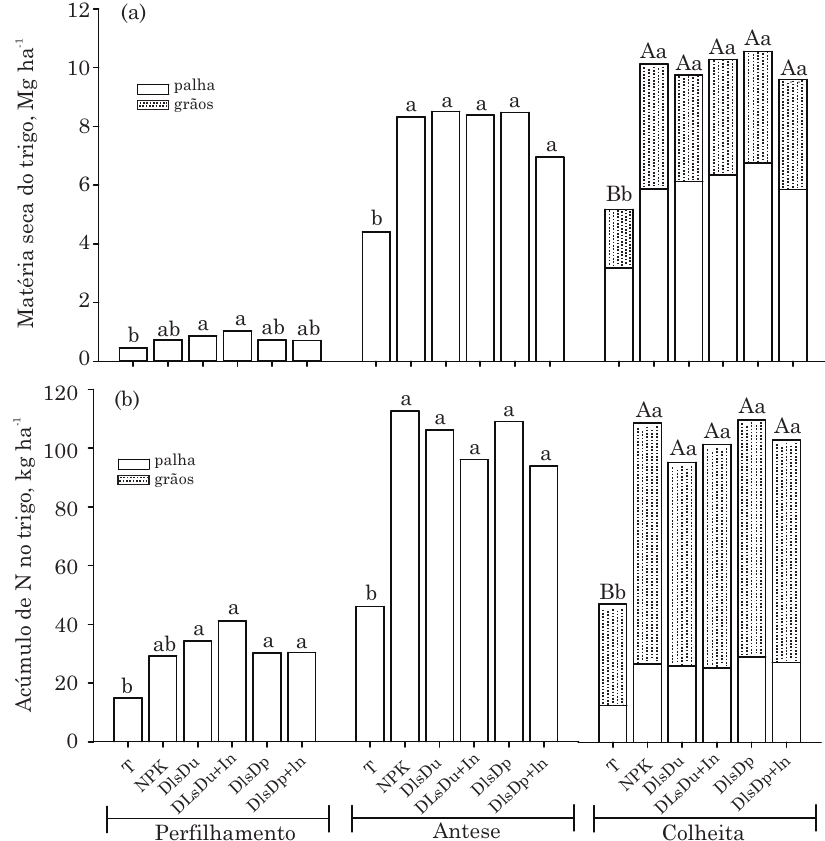
Figura 2. Produção de matéria seca de palha e grãos de trigo (a) e acúmulo de N (b) em diferentes estádios de desenvolvimento da cultura em cada tratamento. Médias de tratamentos seguidas pela mesma letra minúscula, em cada época de avaliação, não diferem entre si pelo teste de Tukey a 5 %. Na colheita, as letras minúsculas comparam a palha e as maiúsculas, os